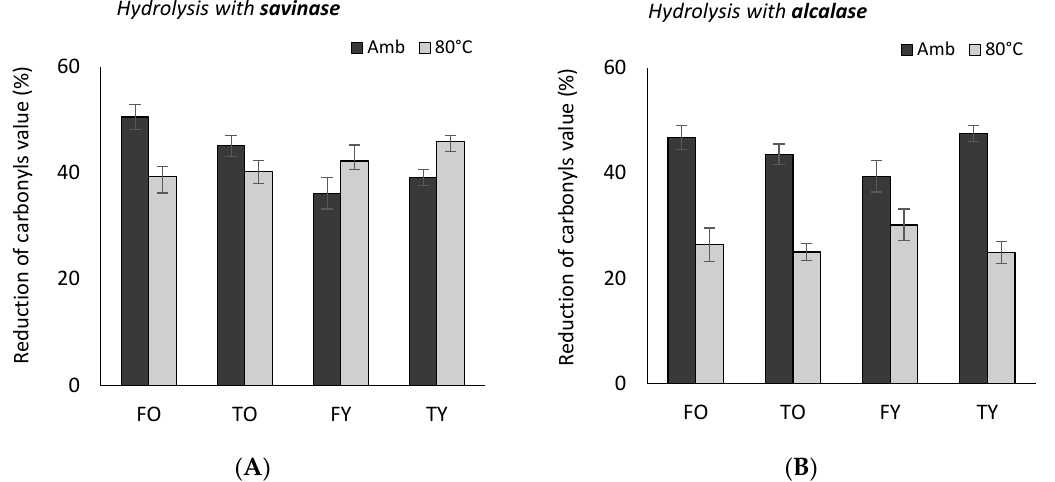
Figure 6. Reduction of carbonyls value (%) in bovine meat (semimembranosus muscle) at ambient temperature and at 80 °C through the addition of collagen peptides solutions (<3000 Da) from young and old bovine femur and tibia obtained through the enzymes savinase ( A ) and alcalase ( B ). FO = old femur, 10 years; TO = old tibia, 10 years; FY = young femur, 4.5 years; TY = young tibia, 4.5 years.